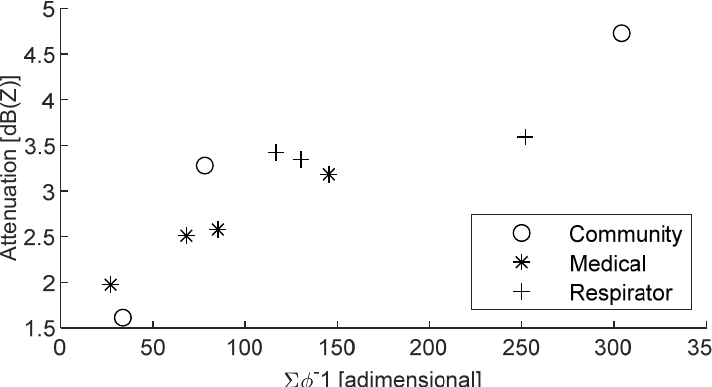
Figure 14. Acoustic attenuation versus the sum of the inverse of porosity.